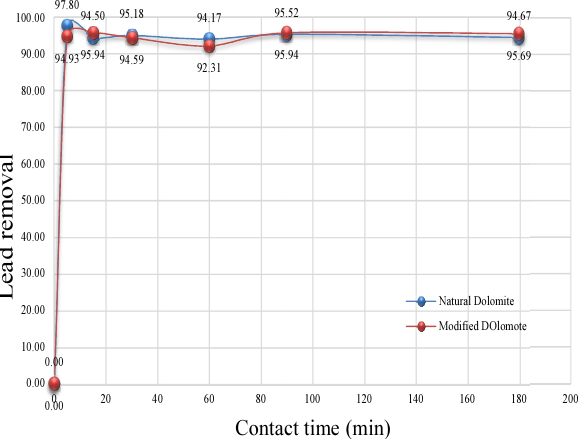
Fig. 3. Comparison of removal efficiency (%) of lead from solution (5 mg/l) by natural dolomite and modified dolomite (1 g) within specified contact times